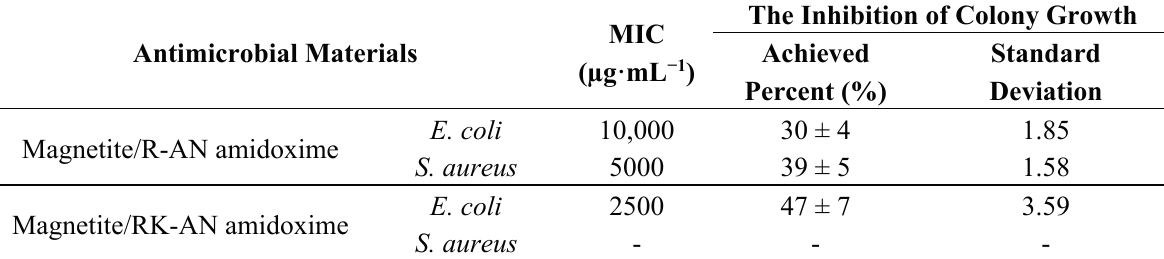
Table 1. MIC (minimum inhibition concentration) values (mg·mL − 1 ) of sample